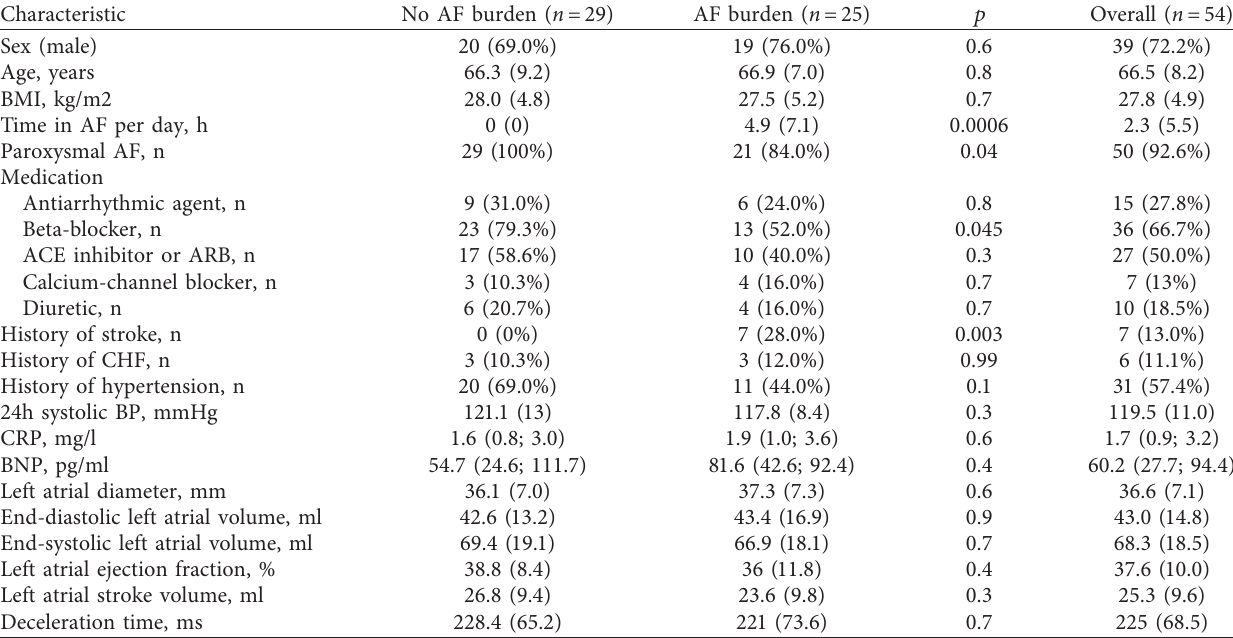
Table 1: Baseline characteristics stratified by the presence or absence of atrial fibrillation in Holter-ECG monitoring at the baseline study visit.